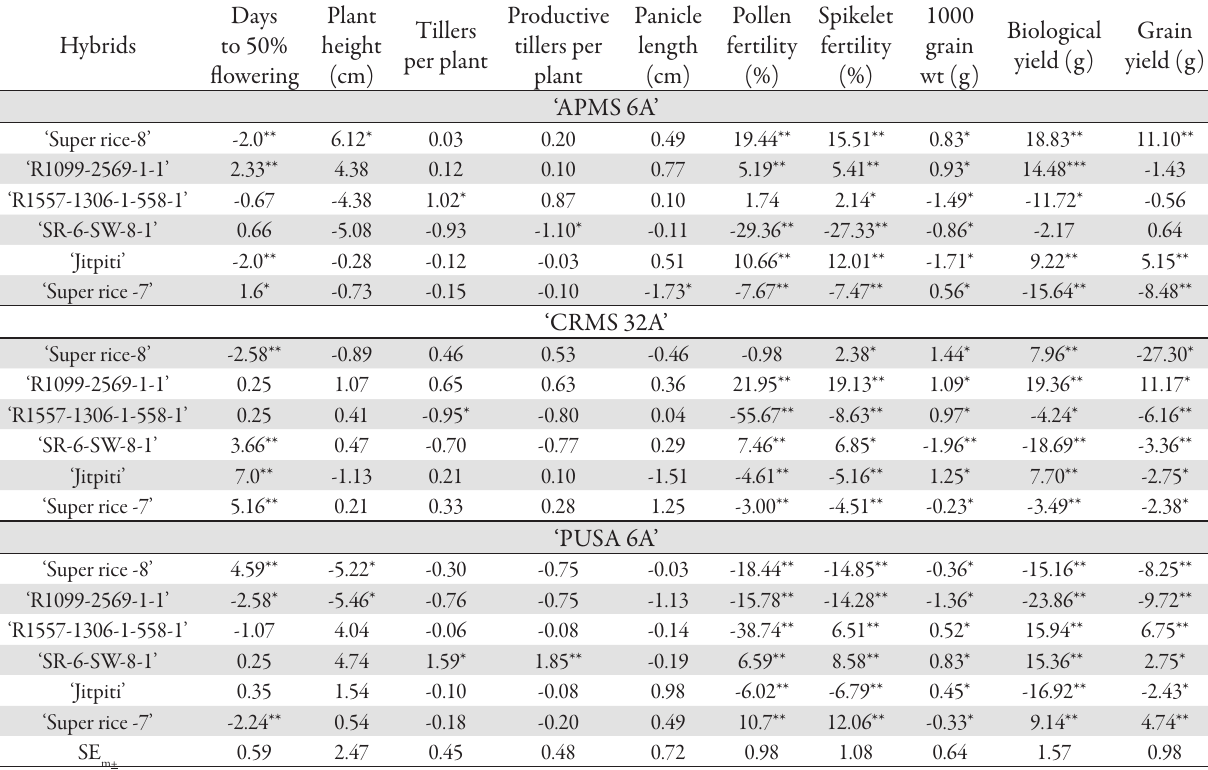
Tab. 2b. Estmates of specific combining ability (SCA) effects for different characters in rice Hybrids